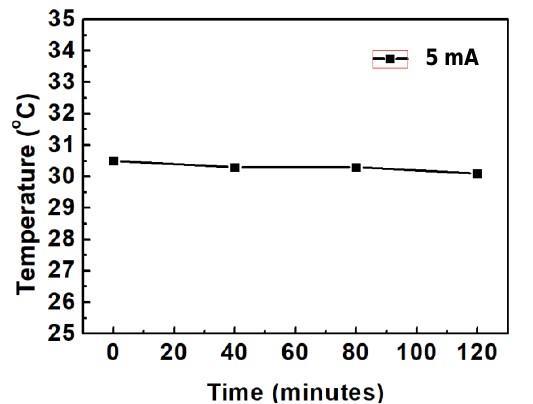
Figure 10. Under 5 mA constant current driven, the surface temperature of OLEDs vs measurement time.